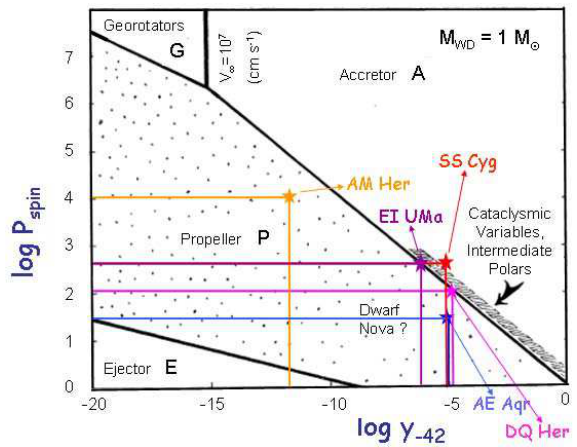
Figure 1: The positions of several CVs in Lipunov’s di- agram calculated for 1 M (cid:12) white dwarf (after Lipunov,